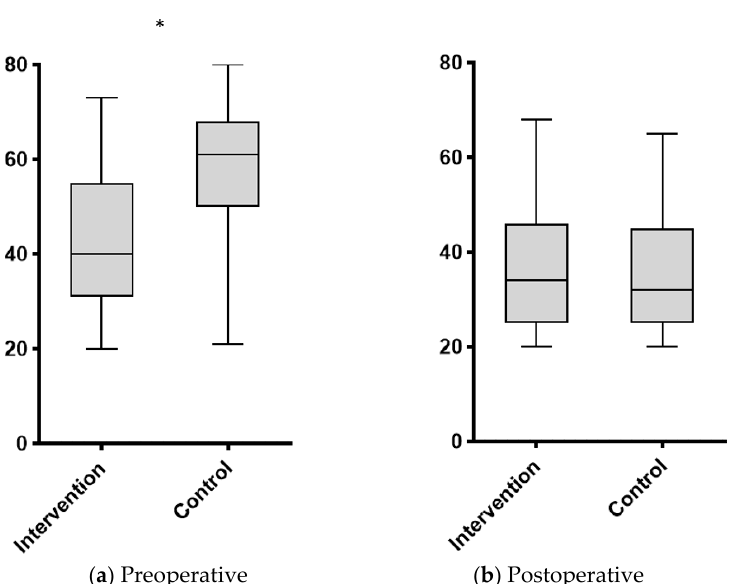
Figure 2. Anxiety before and after major abdominal surgery in patients with or without preoperative nurse dialogue. Whisker plots displaying: ( a ) pre-; and ( b ) postoperative anxiety levels as assessed by the State-Trait Anxiety Inventory Form Y (STAI-Y) questionnaire. * indicates statistical significance ( p < 0.05). y-axis: STAi-Y score.